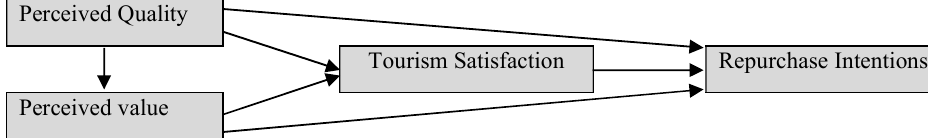
Fig. 1. Conceptual Framework of Jin et al.